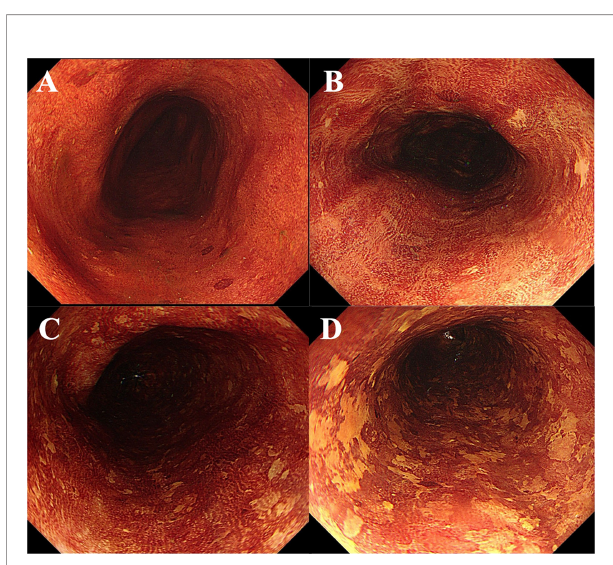
FIGURE 2 | Endoscopic views of Lugol ’ s chromoendoscopy. (A) Absence of LVL. (B) Several (10 or less) small LVLs. (C) Many (more than 10) small LVLs. (D) Numerous irregular-shaped multiform LVLs. LVLs, Lugol-voiding lesions.